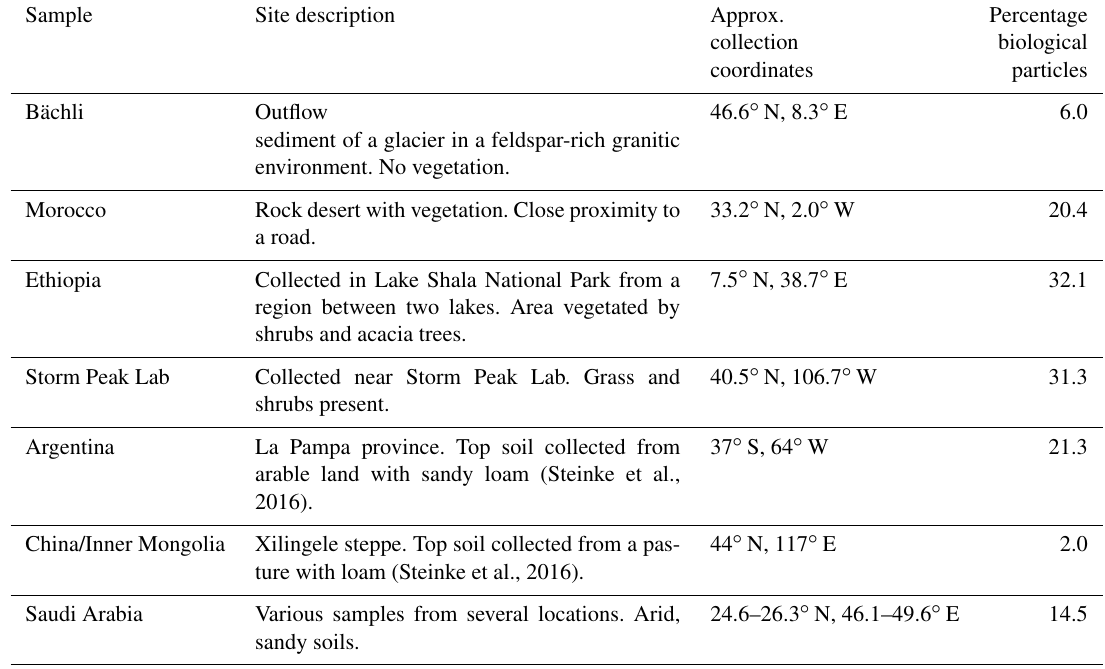
Table 3. Soil dust samples used in this work. The last column shows the results of analysis with the SVM classifier developed here as a percentage of negative spectra